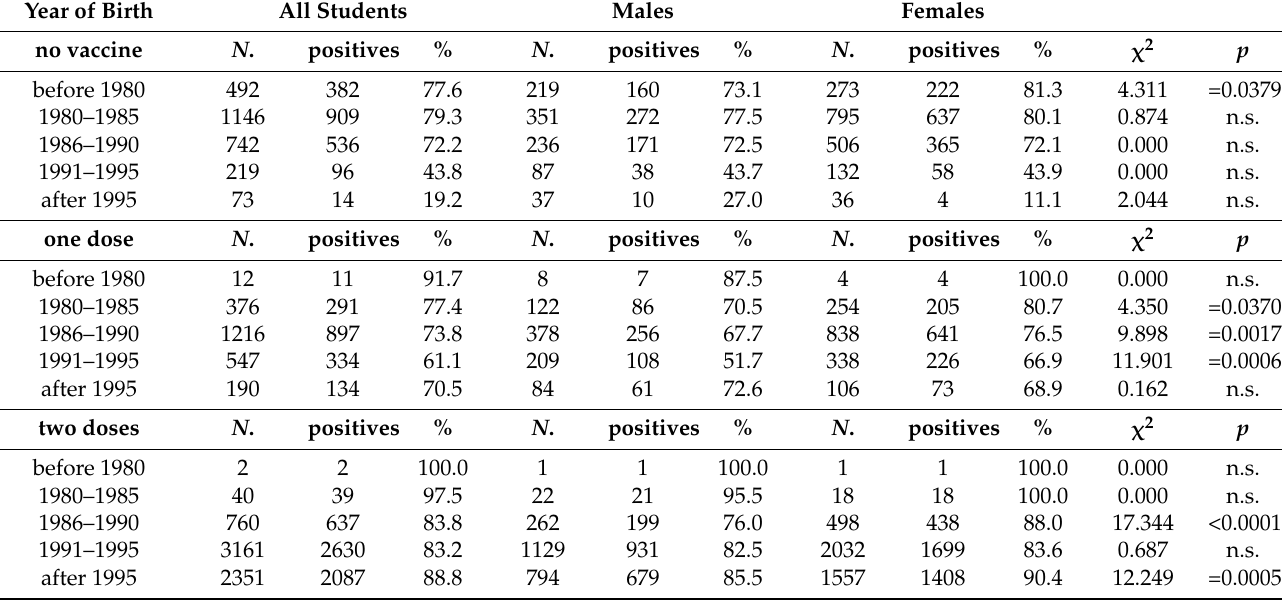
Legened: χ 2 and p refer to the comparison between males and females.